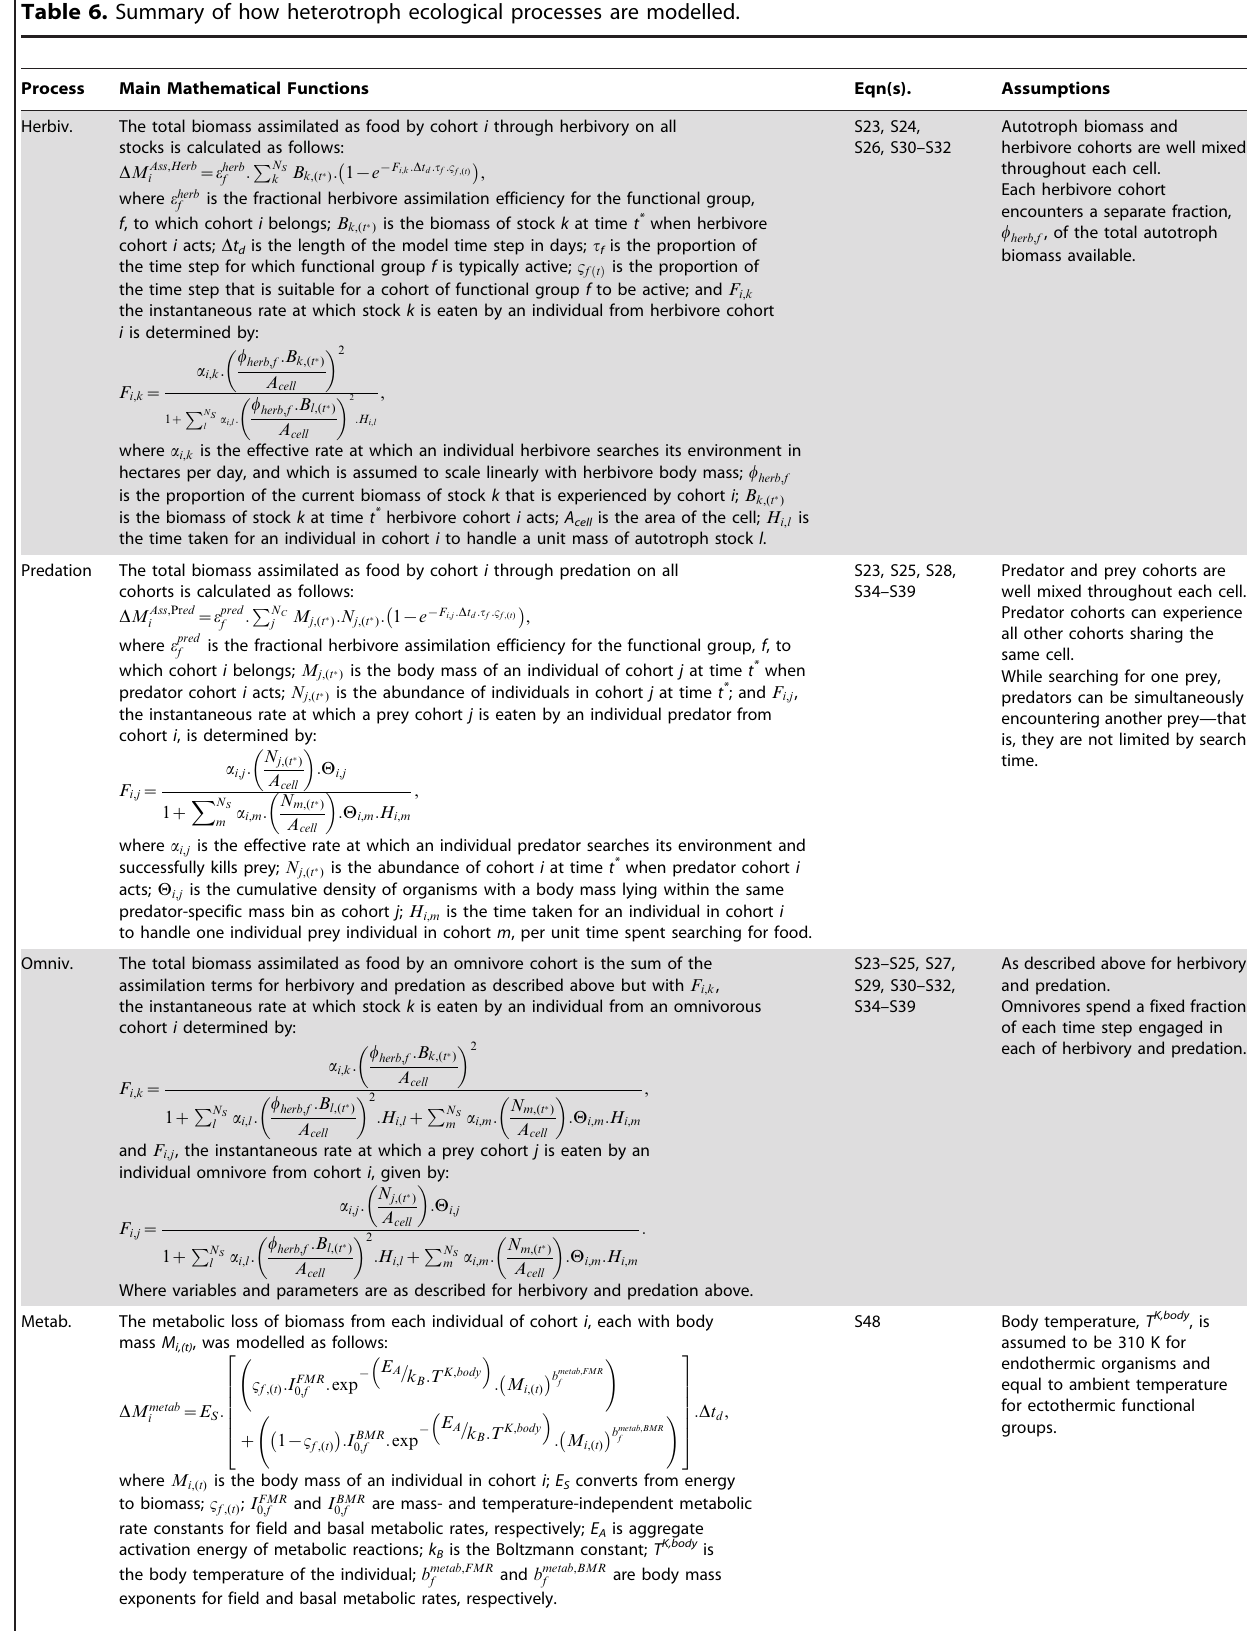
Table 6. Summary of how heterotroph ecological processes are modelled.